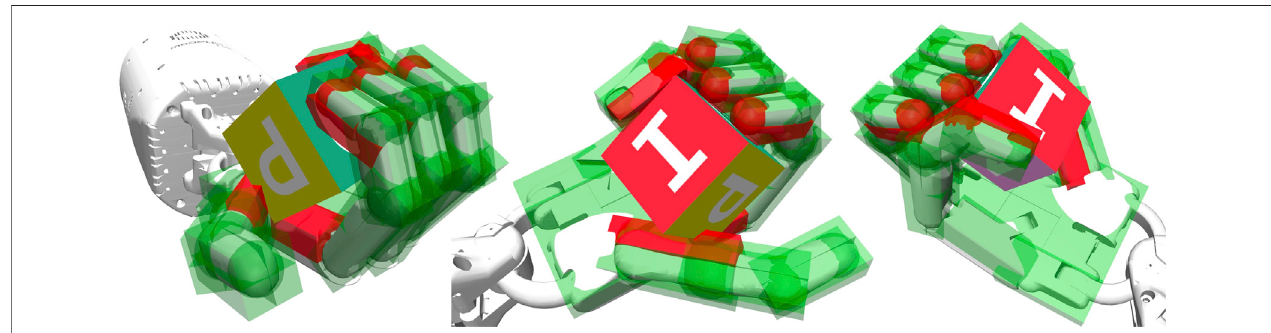
FIGURE 1 | 92 virtual touch sensors covering the Shadow-Dexterous-Hand model. This is a technical visualization of our sensory model. The same tactile event is shown from three different perspectives. Red sites represent activated touch sensors, where a block is pressing against the touch-sensitive area. Green sites represent inactive touch sensors. Video: https://rebrand.ly/TouchSensors.